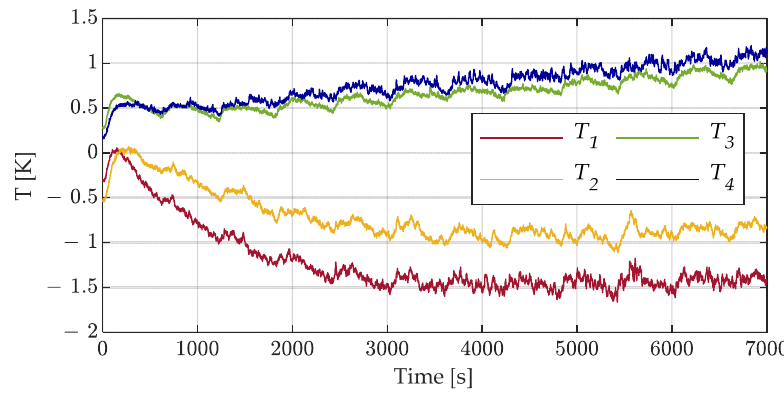
Figure 24. Error test ten cells 70 A.